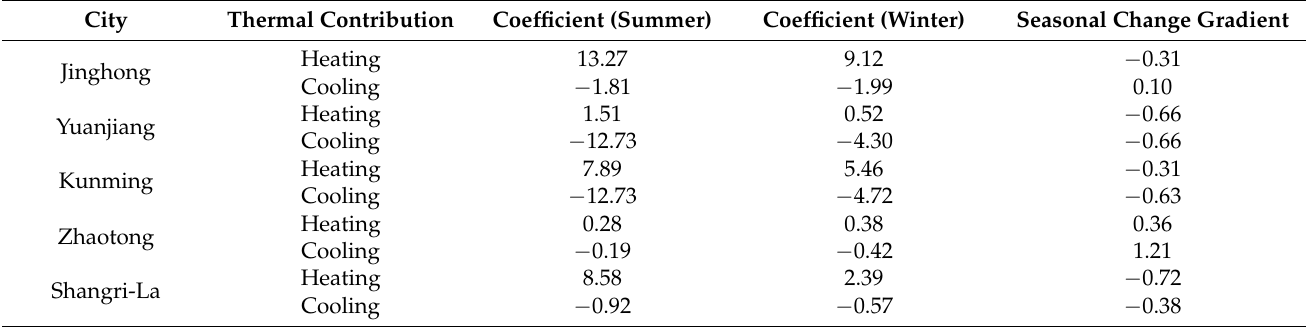
Table 3. The results of the SEM in five